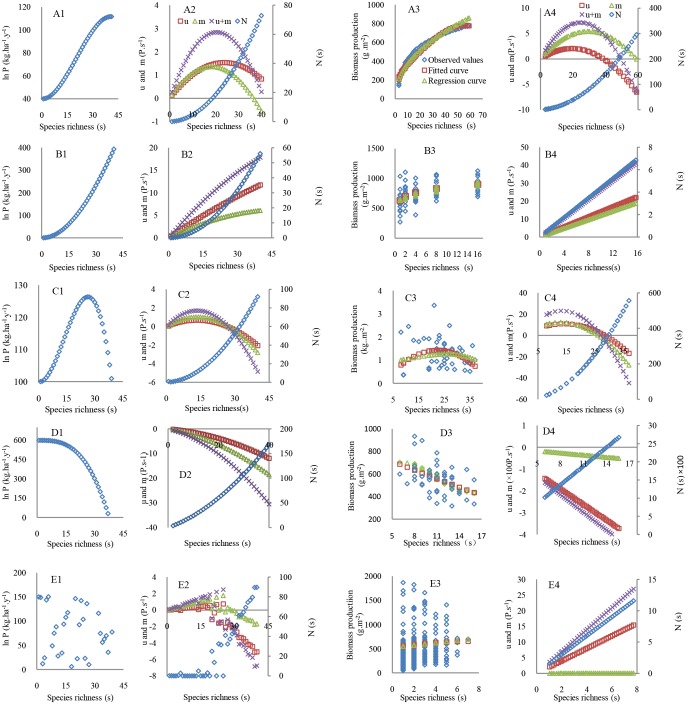
The asymptotic, positive, humped, negative and irregular SRPRs at a local scale controlled by different strengths of SC effect, u(s), density effect, m(s), and the interspecific competition stress N.A1, B1, C1, D1, and E1 were drawn based on the predicted productivity by the first value of the process parameters in each cell of the data columns with #in Table 1 being substituted into Eq 11. A2, B2, C2, D2, and E2 are the dynamics of u(s), m(s), and N corresponding to these different SRPR forms: A1, B1, C1, D1, and E1. A3, B3, C3, D3, and E3 are the observed values of primary productivity along the species richness gradients at local sites in experimental grasslands of Europe [62], the floodplain of the river Saale near Jena in Germany [63], the grasslands in Texas [64], natural plant communities dominated by vascular plants in Gloucestershire of the UK [15], and the Czech Republic [22], respectively (Text B in S1 File). Regression curves are fitted based on the observed primary productivity and fitted curves are drawn using the predicted primary productivity by the second value in each cell of the columns with # in Table 1 being substituted into Eq 11. A4, B4, C4, D4, and E4 indicate the dynamics of u(s), m(s), and N in the five studies described above.